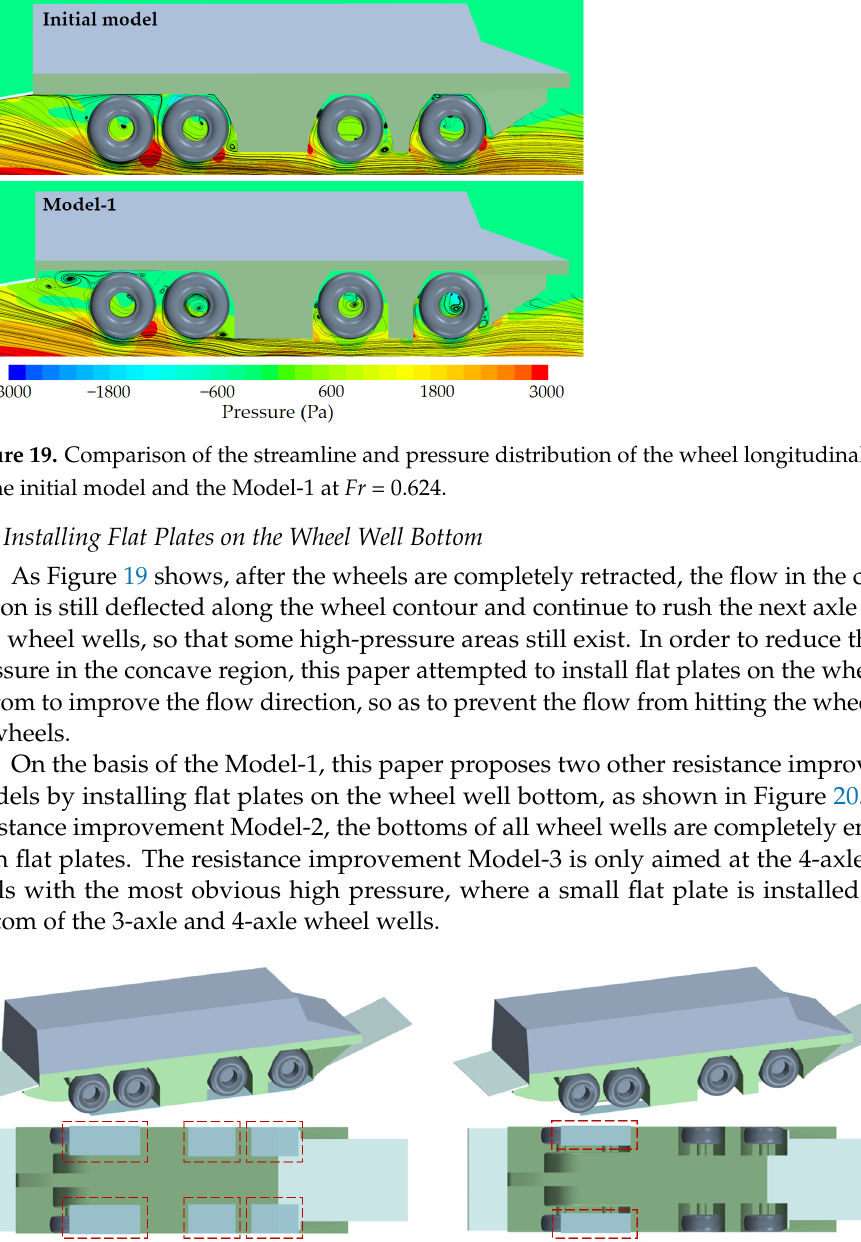
14 of 20 Figure 18. Comparison of resistance between the initial model and the Model-1.